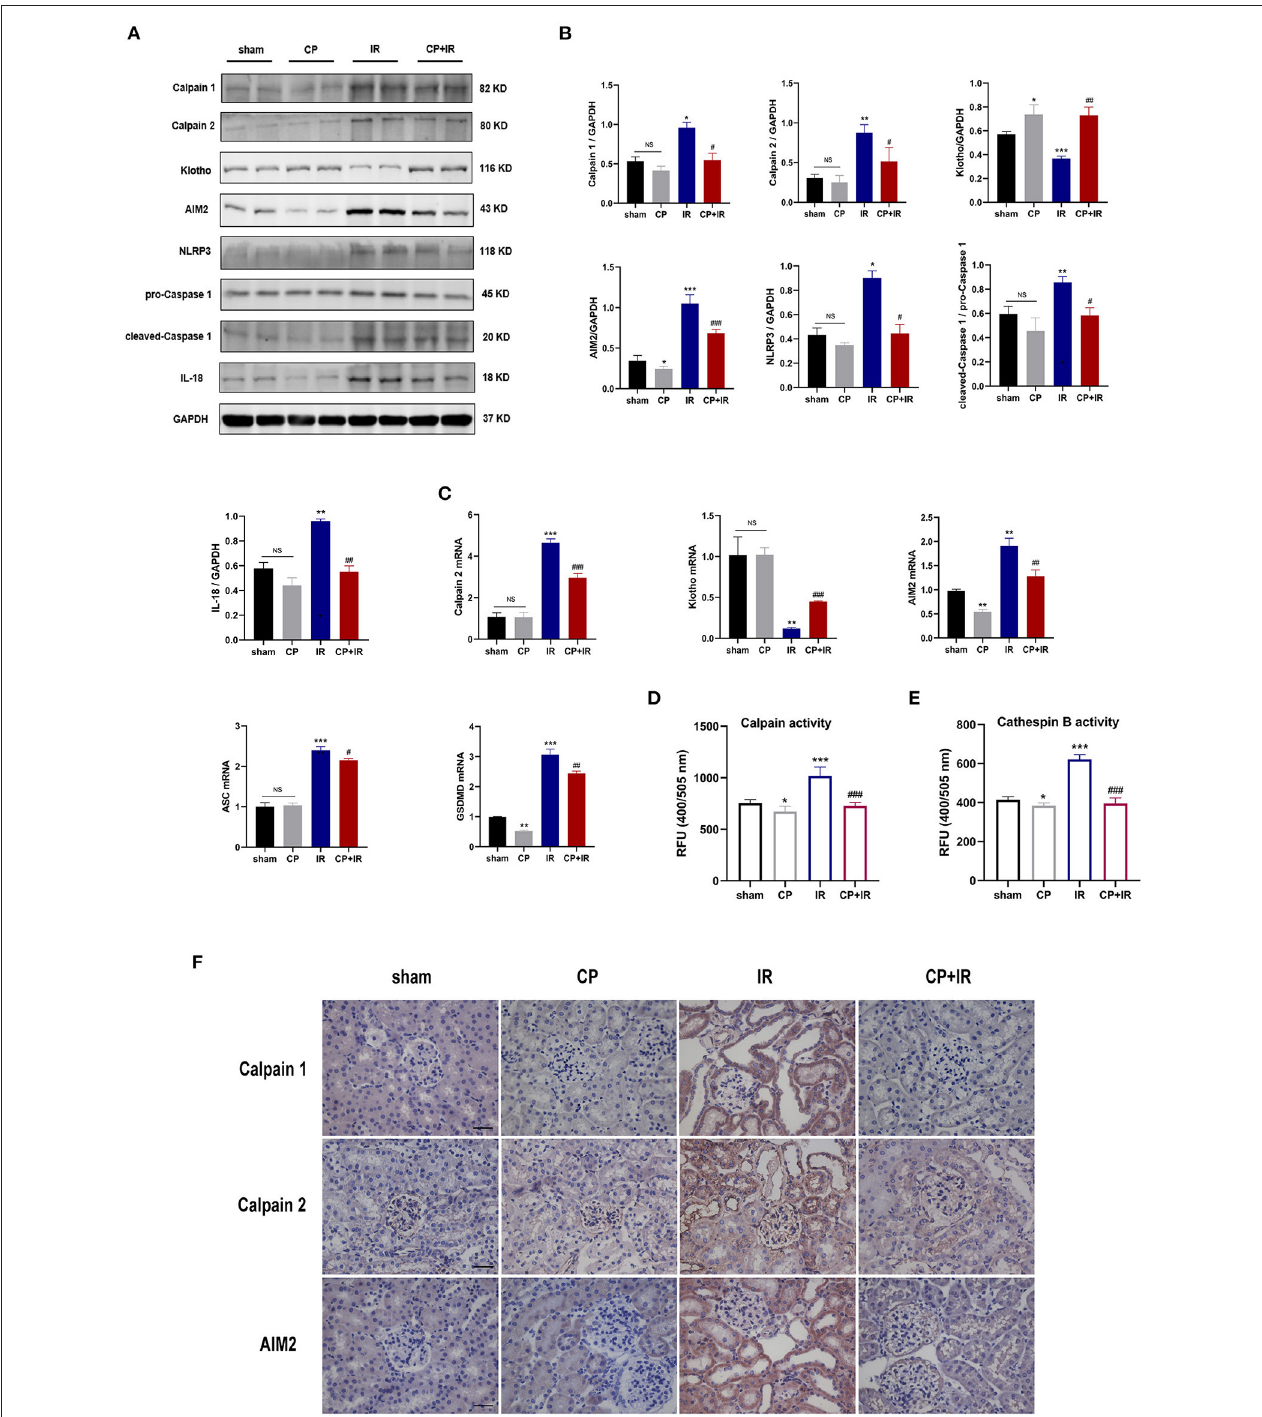
FIGURE 3 | Calpeptin inhibits AIM2 and NLRP3 inflammasome-mediated inflammation, and upregulates Klotho protein expression in IR mouse model. (A) Western blotting of Calpain 1, Calpain 2, Klotho, AIM2, NLRP3, pro-Caspase 1, cleaved-Caspase 1, IL-1 β and IL-18 in the kidney of all mice. (B) Quantitative determination of Calpain 1, Calpain 2, Klotho, AIM2, NLRP3, cleaved-Caspase 1 and IL-18. (C) The mRNA levels of Calpain 2, Klotho, AIM2, ASC and GSDMD in the kidney among different groups. (D) The calpain activity of renal issues was measured by the relative fluorescence units (400/505nm). (E) The cathepsin B activity of kidney issues was tested by the relative fluorescence units (400/505nm). (F) Representative immunohistochemical micrographs from the kidney issues of different groups stained with Calpain 1, Calpain 2 and AIM2. × 400, bar = 50 µ m. All data were presented as mean ± SEM ( n = 3). NS, no significance; * p < 0.05 vs. sham group; ** p < 0.01 vs. sham group; *** p < 0.001 vs. sham group; # p < 0.05 vs. IR group; ## p < 0.01 vs. IR group; ### p < 0.001 vs. IR group. CP, calpeptin; IR, ischemia/reperfusion; RFU, relative fluorescence units.